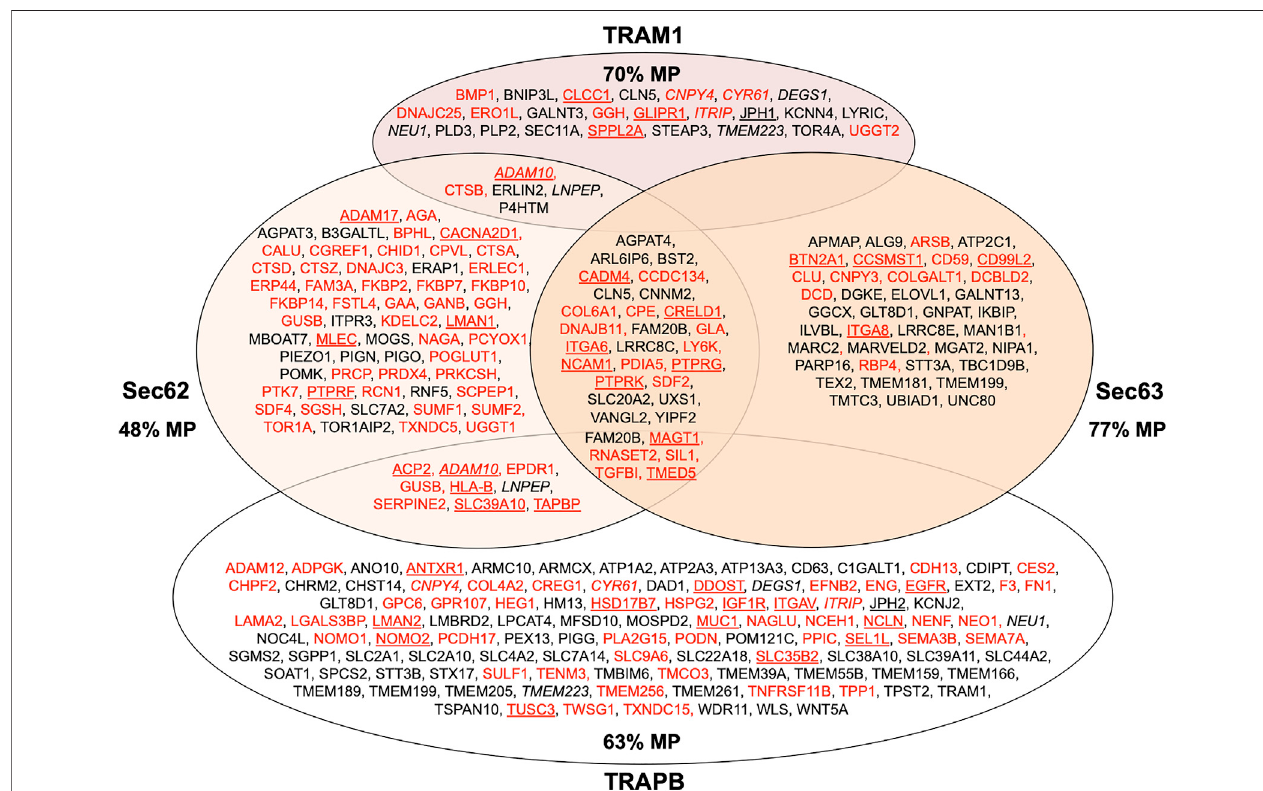
FIGURE9| VenndiagramforhumanERproteintranslocationcomponentsandtheirclients.ThediagramsummarizesprecursorswithSP(inred)orTMH(inblack), which are destined to the secretory pathway and were negatively affected by the indicated depletion; membrane protein precursors with SP are underlined, as are TMH proteins with TA. All these precursor polypeptides are de fi ned as potential clients or substrates of the respective component or complex. The section for Sec62 and Sec63 summarizes the negatively affected proteins after the respective depletions in HeLa cells and the knock-outs in HEK293 cells, respectively (Schorr et al., 2020); the section for TRAM1 summarizes the negatively affected proteins after the TRAM1 depletion in HeLa cells (Klein et al., 2020); the section for TRAP summarizes the negatively affected proteins after the TRAPB depletion in HeLa cells and the TRAPD or TRAPG knock-outs in CDG patient fi broblasts (Nguyen et al., 2018). The percentageofmembraneproteins(MP)ofthesecretorypathwayamongtherespectiveclientsisindicated(%).ADAM10,CNPY4,CYR61,ITRIP,LNPEPandTMEM223 are in italics to highlight that they were negatively affected by TRAM1 as well as TRAPB depletion.